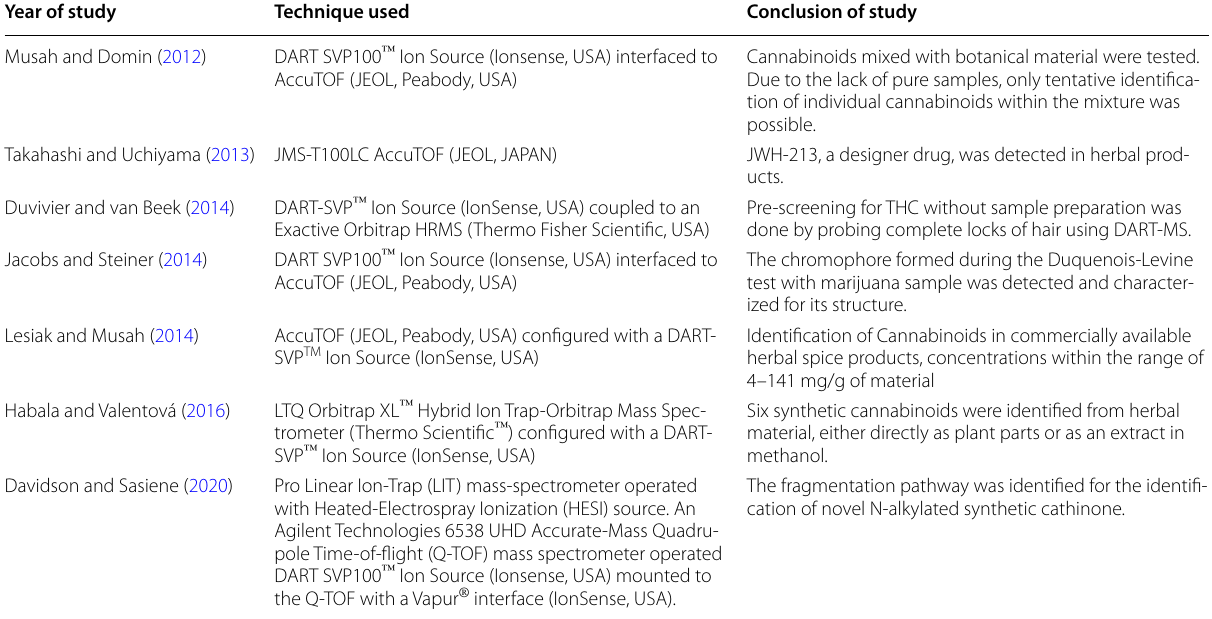
Table 2 Different techniques used for the screening of THC, its derivatives, synthetic cannabinoids, and cannabimimetic Year of study Technique